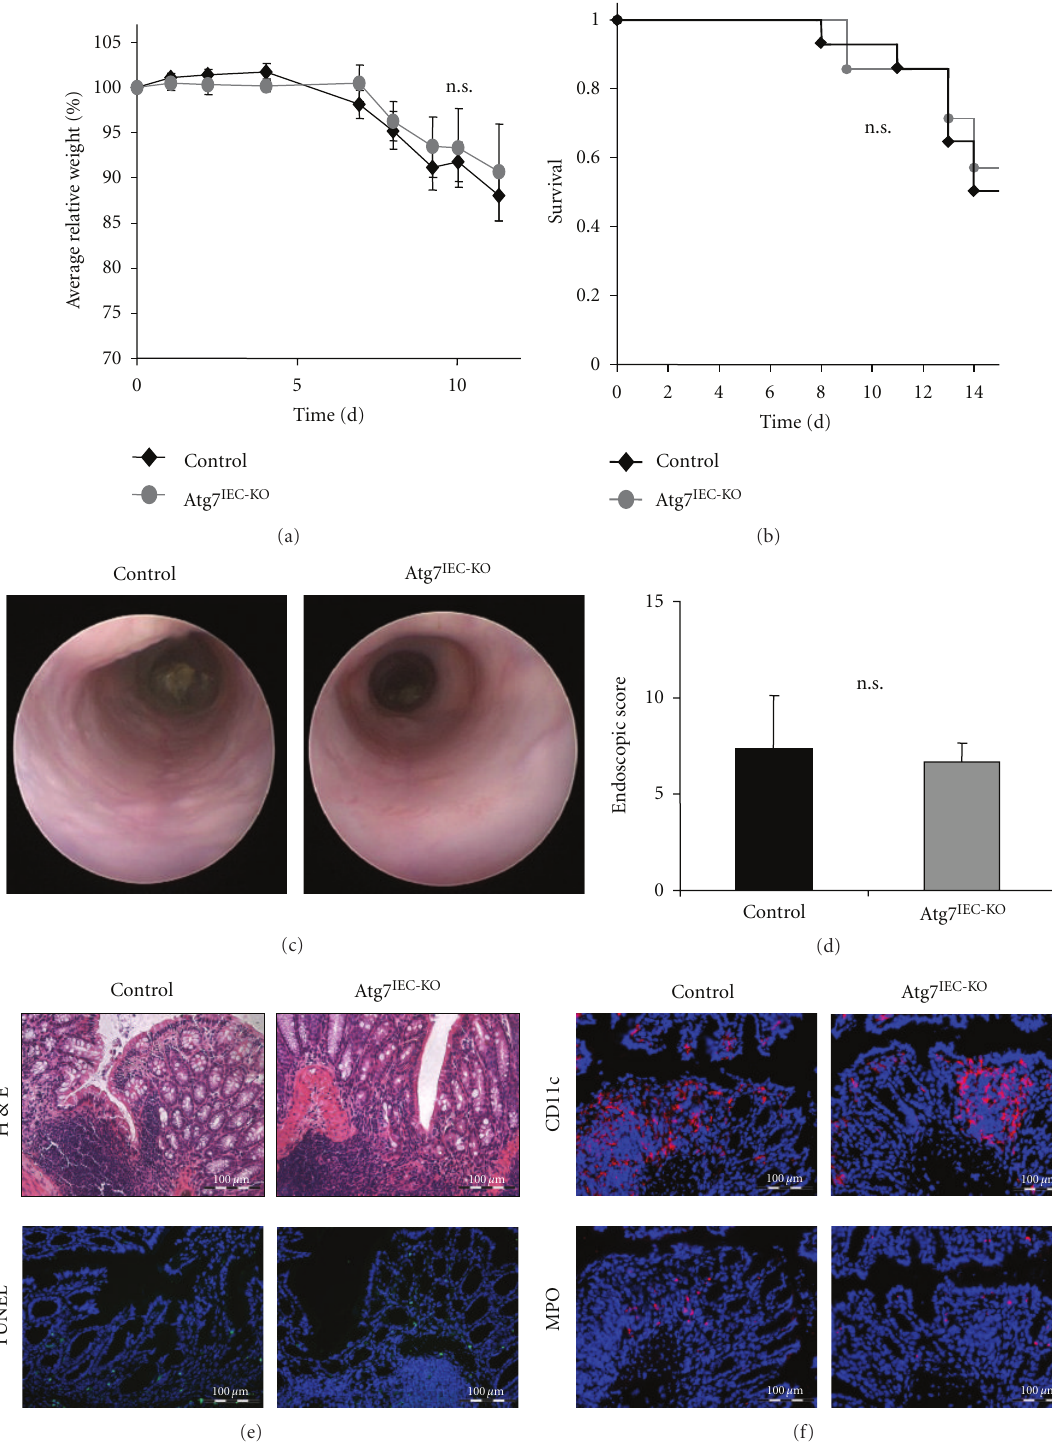
Figure 3: Experimentally induced colitis in control and Atg7 IEC-KO mice. Control and Atg7 IEC-KO mice were continuously challenged with 3% DSS in the drinking water. Illustrated data are representative ( n = 4 independent experiments). (a) Average weight dynamics were calculated from mouse body weights relative to day 0. Data show mean values ± SEM ( n = 14 control mice, n = 7 Atg7 IEC-KO mice). (b) Survival analysis. (c) Colonoscopic pictures of control and Atg7 IEC-KO mice 14 days after beginning of DSS treatment. (d) Scoring of the extent of colitis. Data show mean values + SEM ( n = 3 mice in each group). (e) Histological analysis of the distal part of the colon from control and Atg7 IEC-KO mice, treated with DSS for 14 days, by H & E staining (upper row) and TUNEL (bottom row). (f) Infiltration of CD11c+ cells (red, upper row) and MPO+ cells (red, bottom row) into the colon of DSS-treated control and Atg7 IEC-KO mice was detected by immunohistochemical analysis. Nuclei are shown in